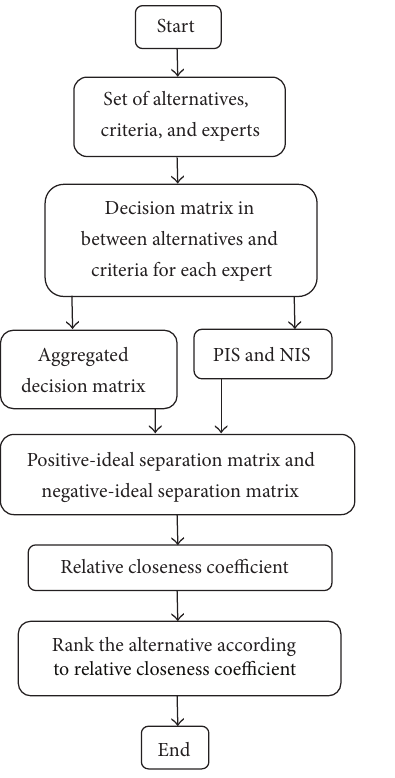
Figure 1: Flow chart of TOPSIS for TVHFS.